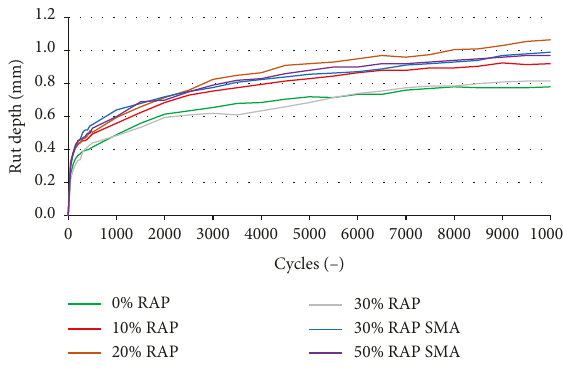
Figure 4: Course of the wheel tracking test at a temperature of 50 ° C. Table 6: Stiffness of SMA 11 mixture variants with various RA ratios (RAP and RAP SMA). Mixture